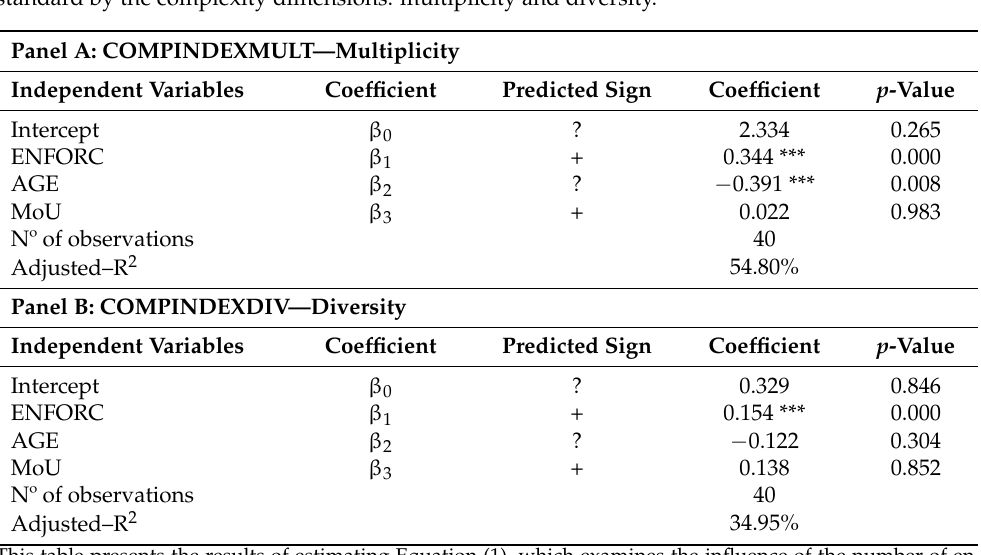
Table 5. Association between the number of enforcements and the complexity of an accounting standard by the complexity dimensions: multiplicity and